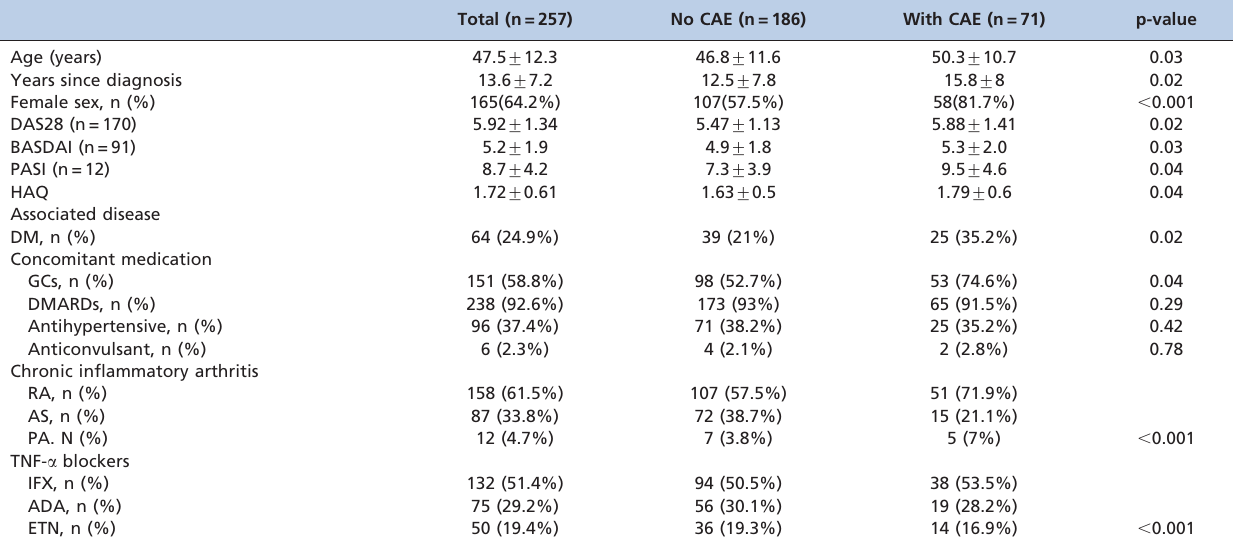
Table 2 - Clinical characteristics of the 257 patients with chronic inflammatory arthritis taking TNF- a blockers according to the presence of